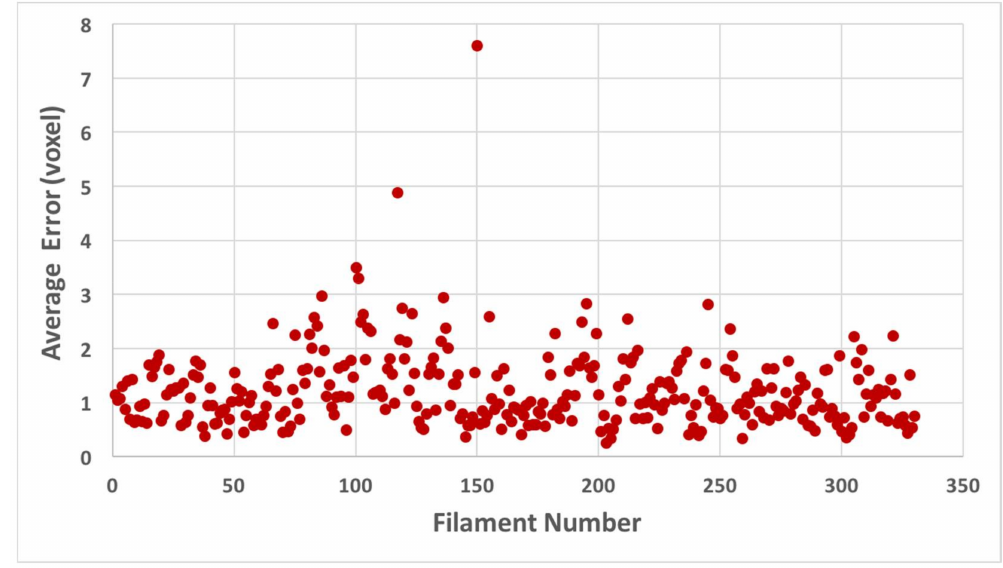
Figure 4. Average cross-distance between a filament detected using BundleTrac and its corresponding manually detected filament for 330